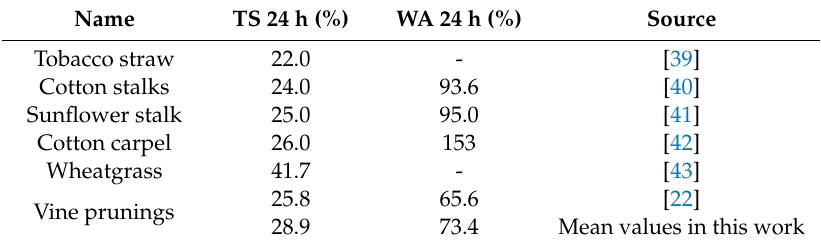
Table 4. Thickness swelling (TS) values obtained with plant fiber